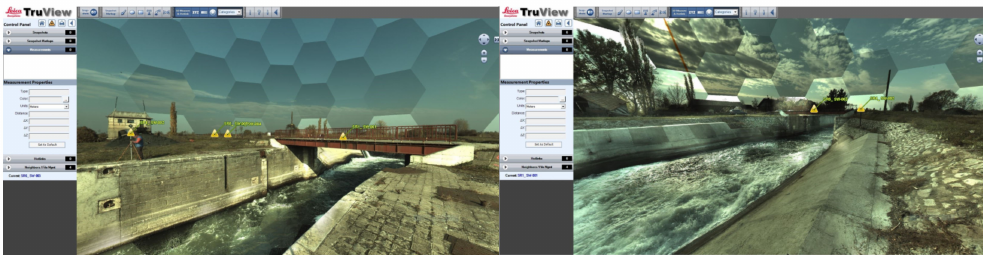
Figure 22. TruView link for the Lock from S â nmihaiu Rom â n.